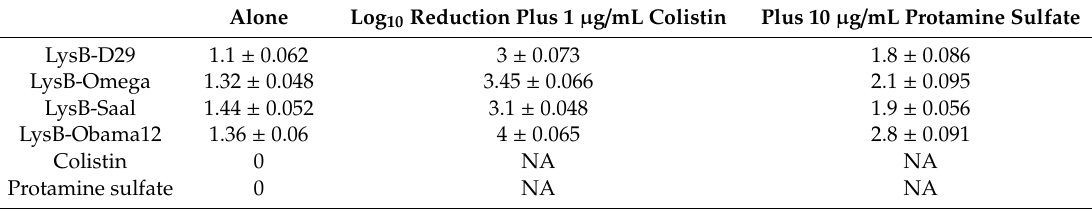
Table 4. Log 10 reduction of M. smegmatis after treatment with 100 µ g / mL of LysB-His 6 enzymes alone and in combination with Colistin (1 µ g / mL) and Protamine sulfate (10 µ g / mL), respectively in Cation Adjusted Mueller–Hinton Broth (CAMHB), NA: not available.